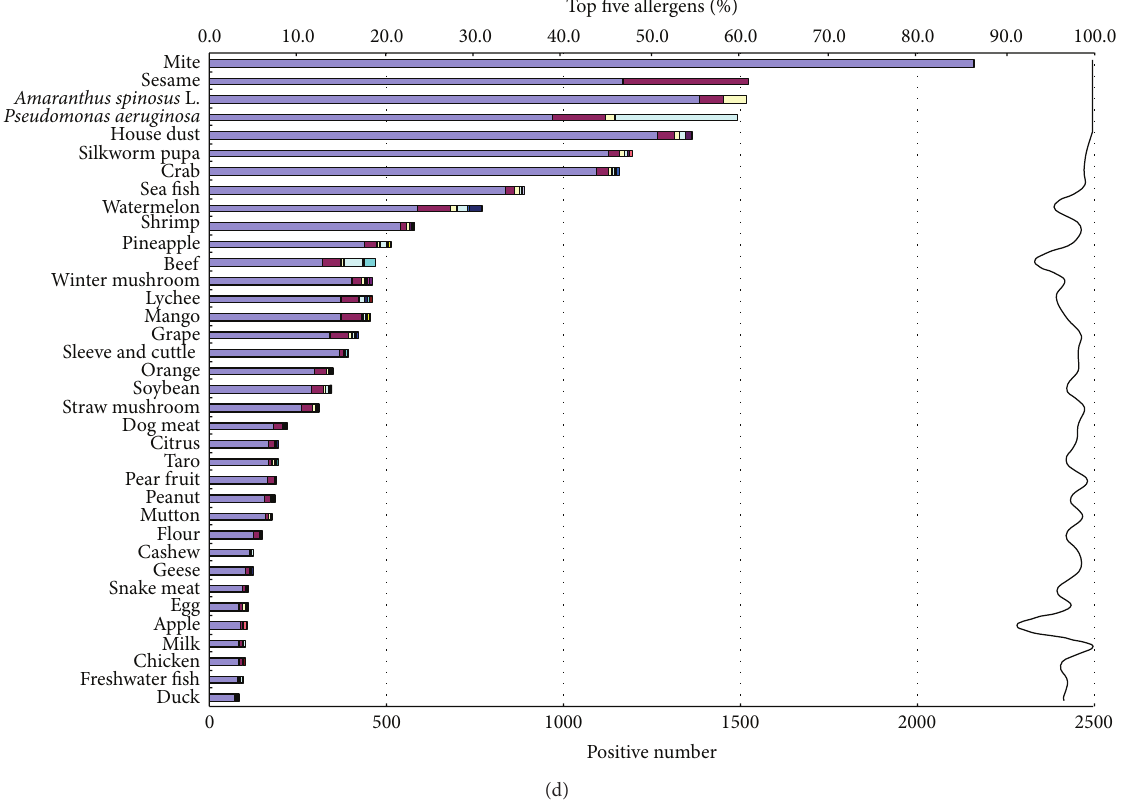
Figure 1: IDT results of 62 allergenic sources on 3,335 patients. The allergenic sources were grouped into 4 panels: (a) pollen; (b) contactant; (c) microbes; (d) food. The top 5 most potent allergenic sources were compared to all other allergenic sources and displayed on each panel. “ A&B hair ” in (b) denotes mix of animal fur and bird feather. The same bar color represents cosensitization among different allergenic sources. And the length of different color bars indicates the proportion of positively sensitized subjects. The different color at the very top of each bar represents the specific positives of each allergenic source. The rightmost curve denotes the total proportion in each allergenic source of the positive cases cosensitized to the top five allergenic sources. Spring pollen is produced by Acacia confusa Merr., pine tree, cedar, paper mulberry ( Broussonetia papyrifera ), waxberry ( Morella rubra ), Chinese Mulberry ( Morus australis Poir.), and Chinese fan palm ( Livistona chinensis R.). Summer pollen originates from maize, Australian pine ( Casuarina equisetifolia ), Chinaberry ( Melia azedarach ), and Eucalyptus camaldulensis Dehnh. Autumn pollen comes from Mallotus apelta , Humulus scandens , mugwort ( Artemisia vulgaris ), Vitex negundo , and Dioscorea benthamii . Winter pollen is from cajeput ( Melaleuca leucadendra L.) and Bauhinia blakeana